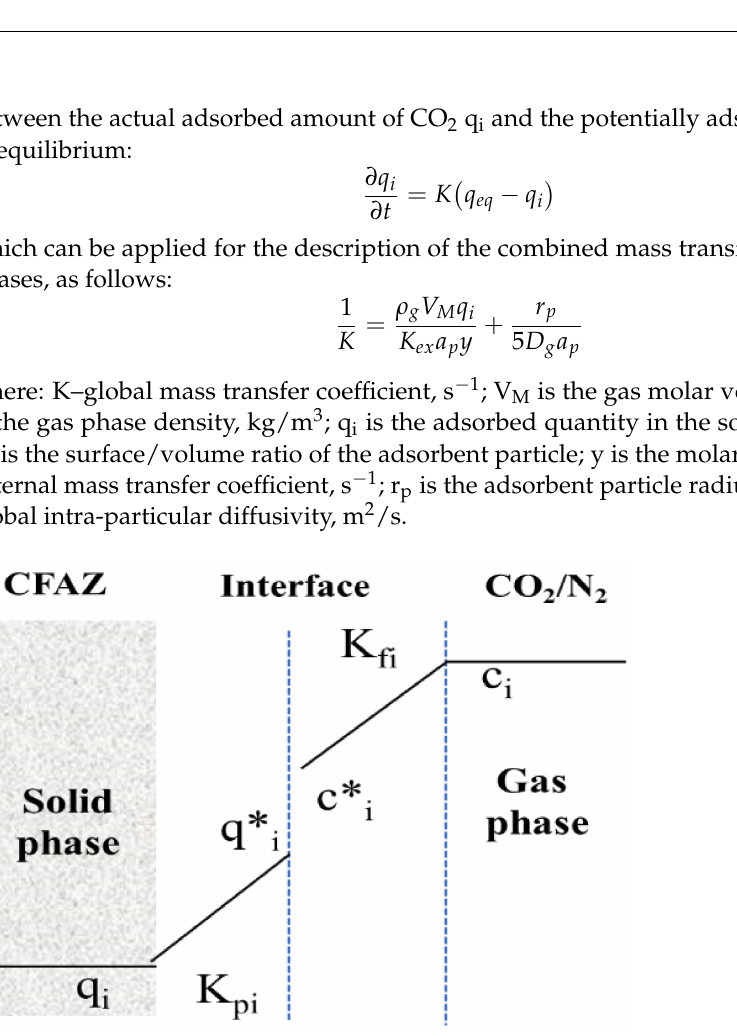
Figure 9. Mass transfer zones in a simulation model of dynamic adsorption in the CO 2 -CFAZ system, and q ∗ where C ∗ are the gas phase partial concentration and the gas content in solid at the gas-solid i i interface,